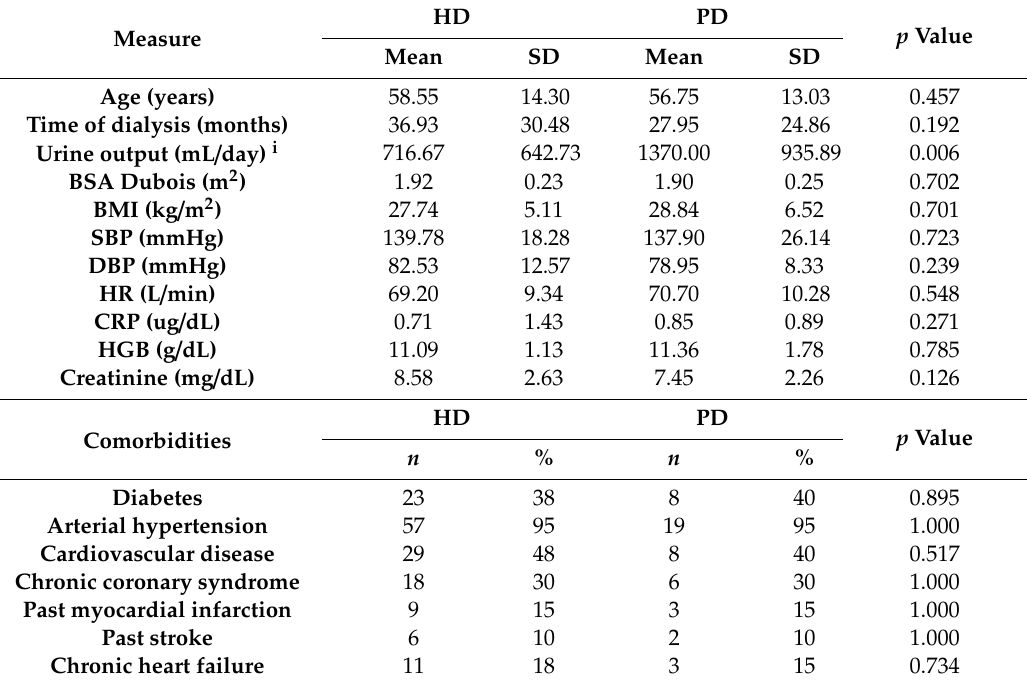
Table 6. Basic characteristics of the study